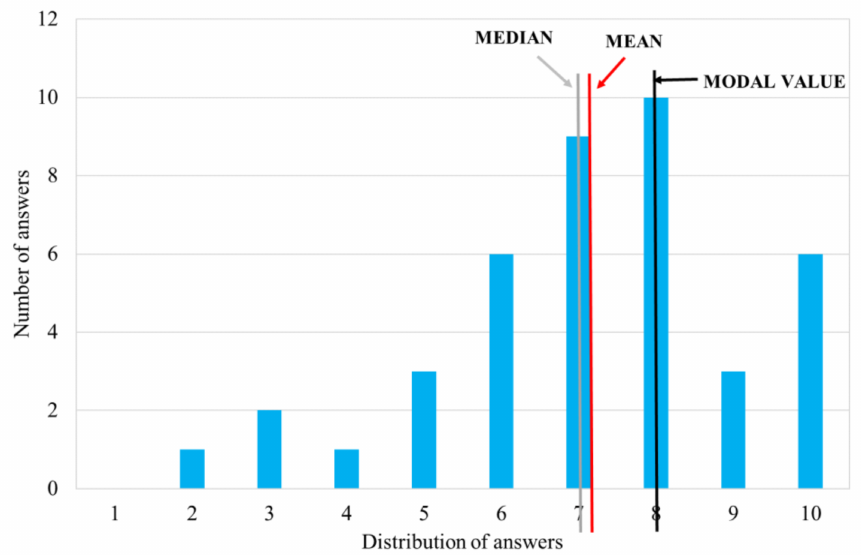
Figure 8. The distribution of the frequency of answers to the question: “On a scale of 1–10, assess your willingness to implement in this company a system which improves energy efficiency and helps solve problems with system